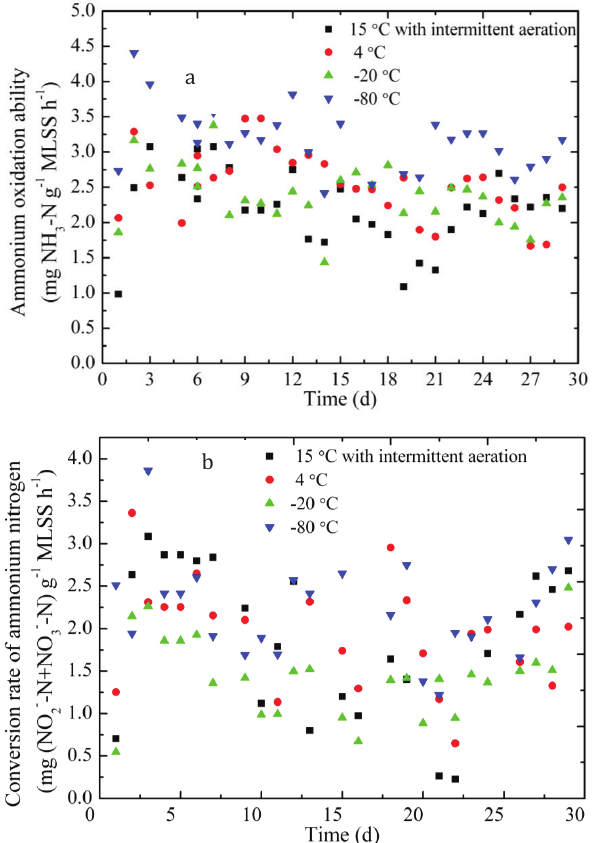
Fig. 3 – Ammonium oxidation ability and conversion rate of ammonium nitrogen during the reactivation